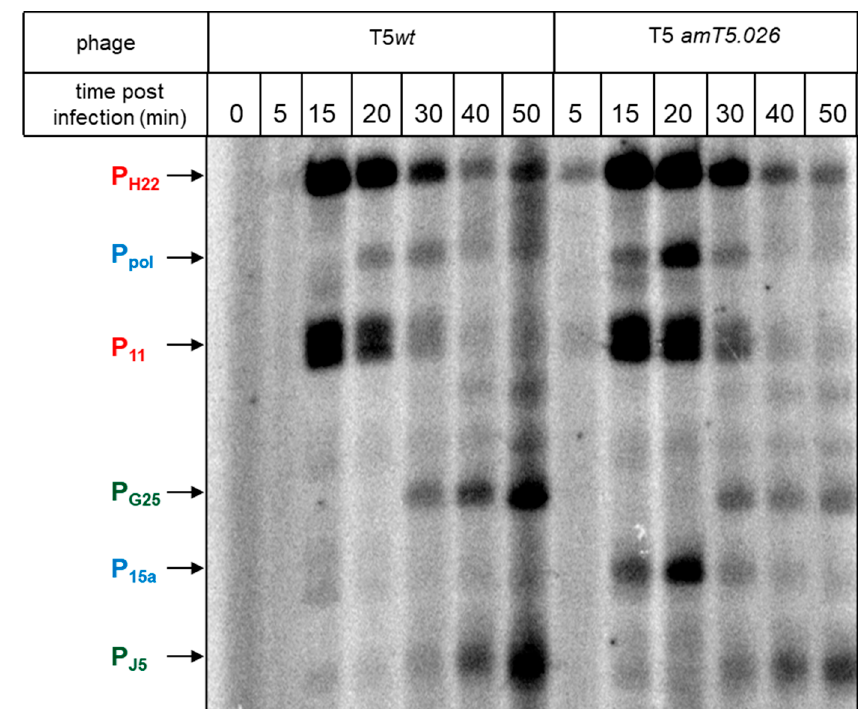
Figure 6. Analysis of transcription in E. coli cells infected with phage T5 wt and T5 amT5.026 . RNA was isolated from uninfected (0) and infected cells collected 5, 15, 20, 30, 40, and 50 min after the infection. Detection of transcripts from the promoters of di ff erent temporal classes was carried out by primer extension assay with a mixture of 32 P-labeled primers. The reaction products were separated in 7% denaturing polyacrylamide gel and visualized using a Phosphorimager. Primer extension products are indicated by arrows, and the promoters they arise from are labeled (pre-early-P 11 and P H22 , early-P 15A and P pol , and late-P G25 and P J5 promoters). Quantification of transcript kinetics is shown in Figure S3.